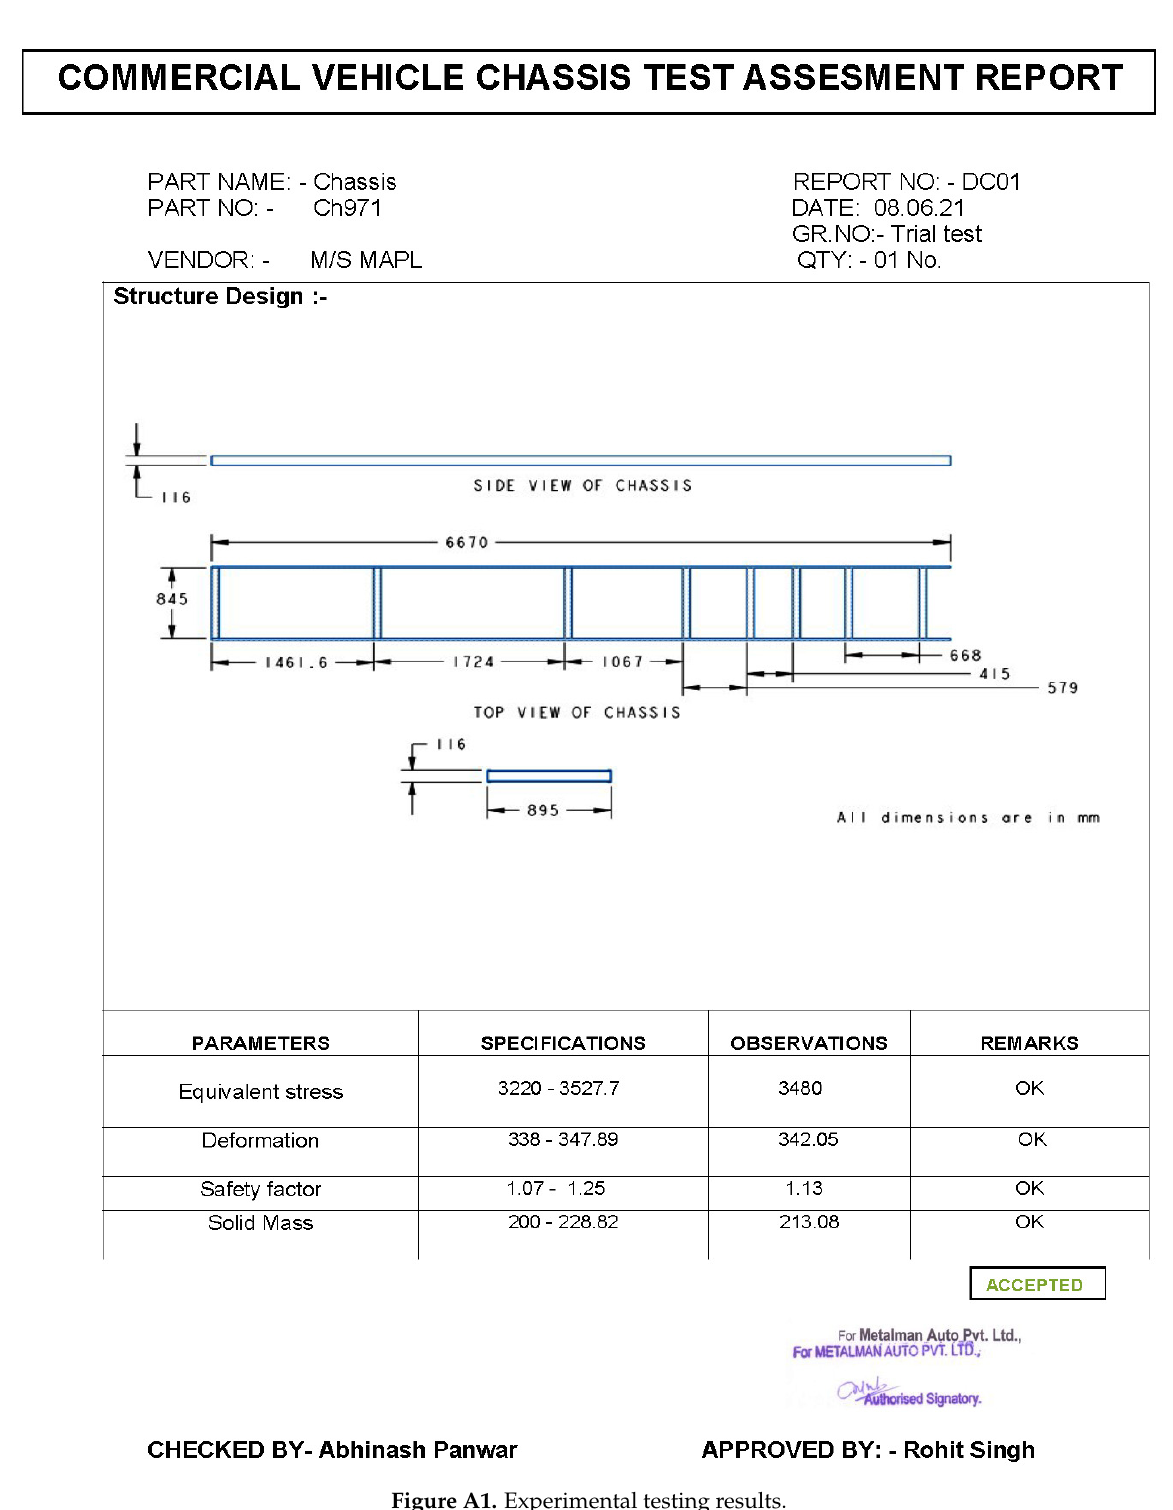
Figure A1. Experimental testing